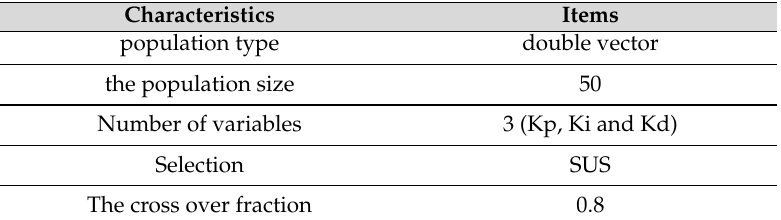
Table 3. Parameters of the GA used for GA-PID